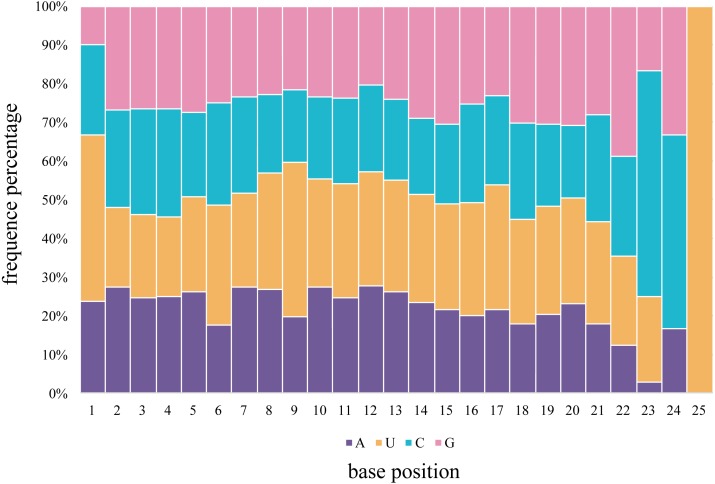
The percentage distribution of base composition at each position of M. undulatus miRNAs in all combined tissues.